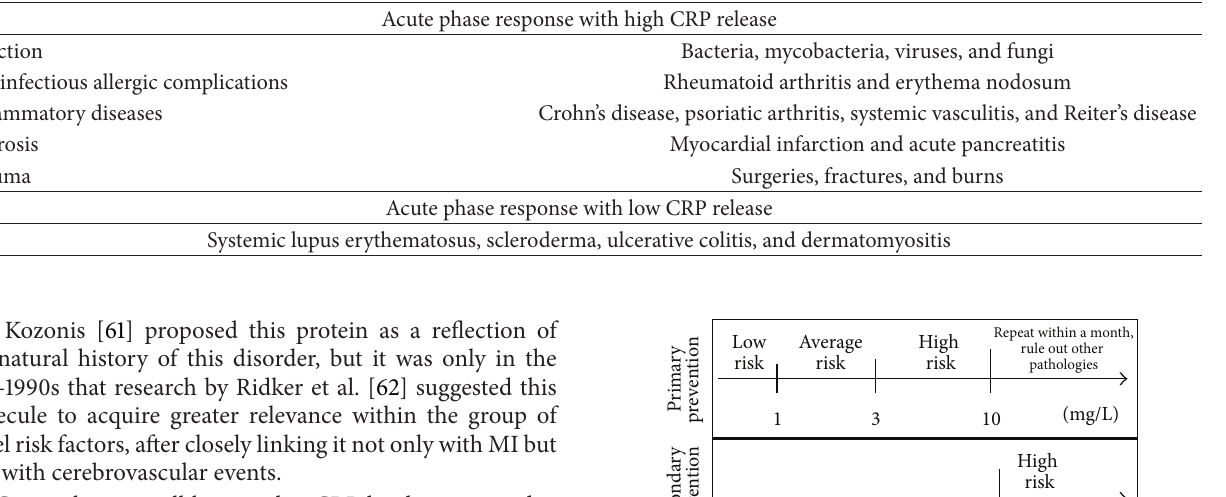
Table 2: C-Reactive Protein in certain pathologies.